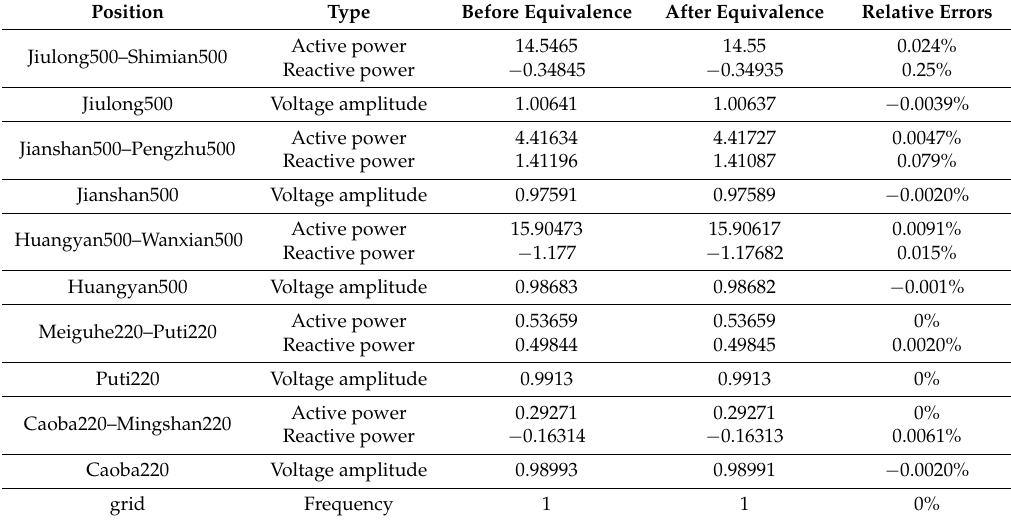
Figure 9. The simple map. Table 4. The part of power flow results before and after equivalence (p.u).